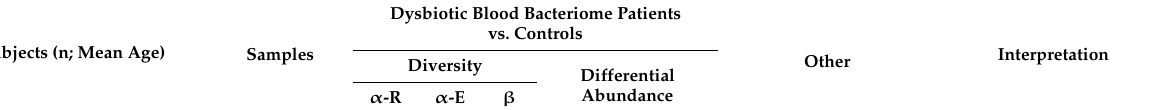
Table 3. Blood Bacteriome Dysbiosis Profiles in Age-Related Metabolic